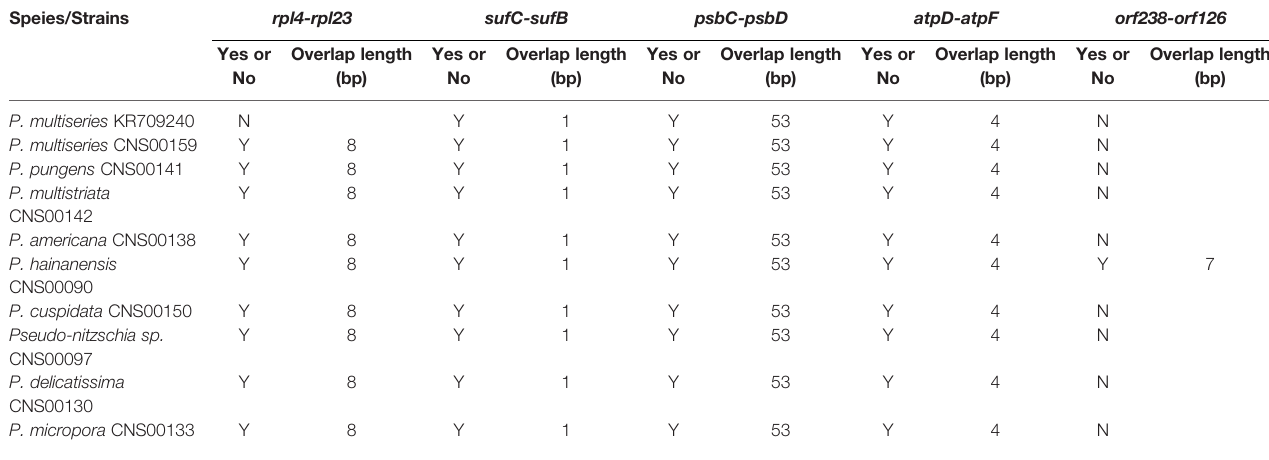
TABLE 4 | Overlapping genes in the cpDNAs of Pseudo-nitzschia species. “ Y ” or “ N ” represents whether the two genes were overlap. Speies/Strains